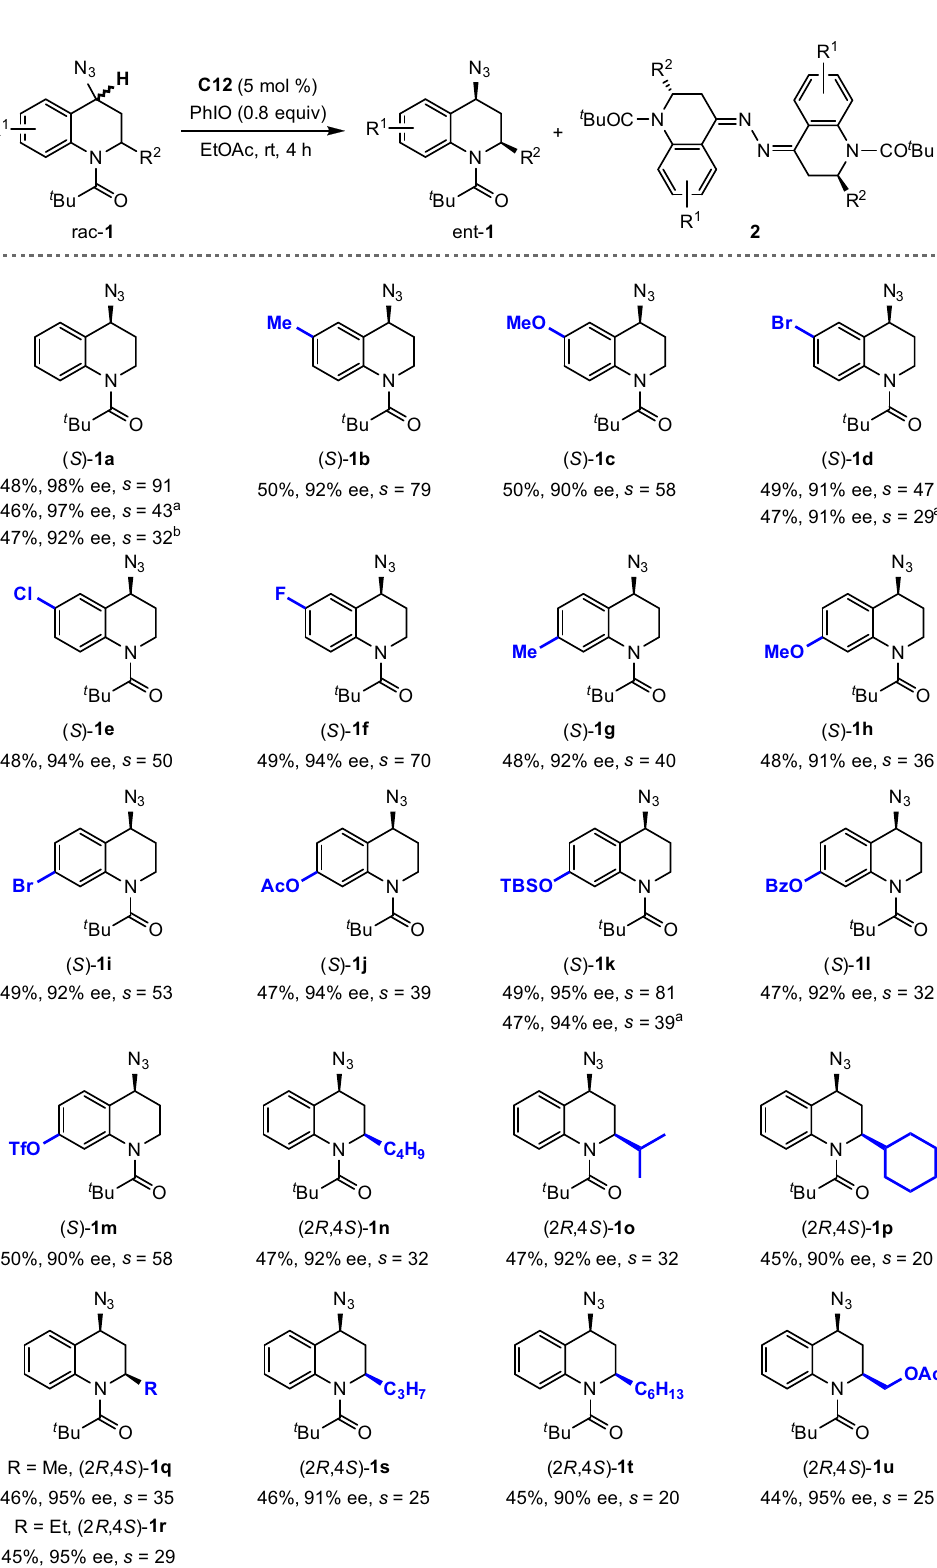
NATURE COMMUNICATIONS| (2022) 13:1621